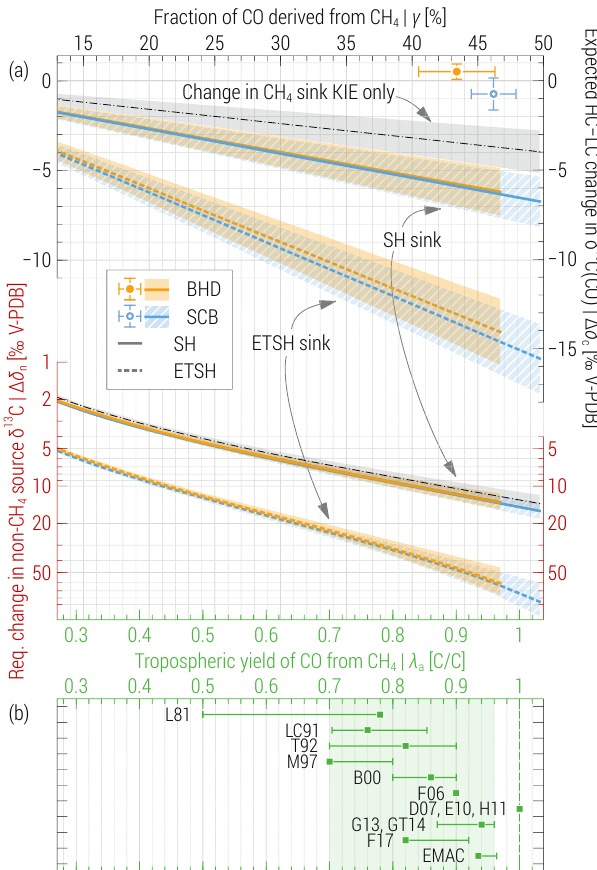
Figure 2. (a) Top: expected CH 4 + Cl sink-driven changes to δ 13 C(CO) between HC and LC periods at the ETSH stations ( (cid:49)δ c ) as a function of CH 4 -derived CO fraction ( γ , top axis) resulting from assumed yield values ( λ a , bottom axis, approximate). Large symbols denote the observed (ordinate) and simulated (abscissa, EMAC) values. Thick lines present (cid:49)δ c values calculated using Eq. (2) assuming that hypothesised changes to the CH 4 + Cl sink occur within the entire SH (solid) and ETSH only (dashed). Thin dashed–dotted lines exemplify the effect due to mere changes in CH 4 sink KIE ( (cid:49)ε m ) . Bottom: average augmentation to the non- CH 4 sources signature ( (cid:49)δ n ) required to compensate (cid:49)δ c at the re- spective values and domains (note the different axis shown in red). Errors bars and areas denote ± 1 σ of the annual means and derived estimates. See Sects. 2.4 and 3 for details. (b) Tropospheric yield of CO from CH 4 oxidation reckoned in the current and previous studies. Symbols (error bars) denote the best (range of) estimates or the global (domain) averages. Abbreviations refer to the